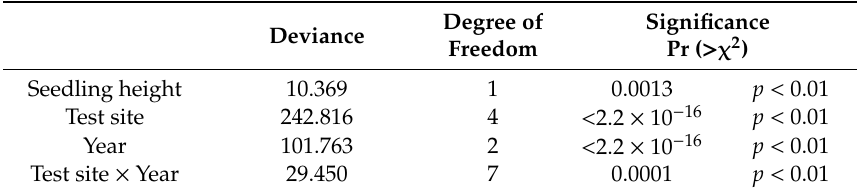
Table 2. E ff ects of site and inoculation year on una ff ected seedling rate analyzed using a generalized Table 2. Effects of site and inoculation year on unaffected seedling rate analyzed using a generalized linear mixed linear mixed model.